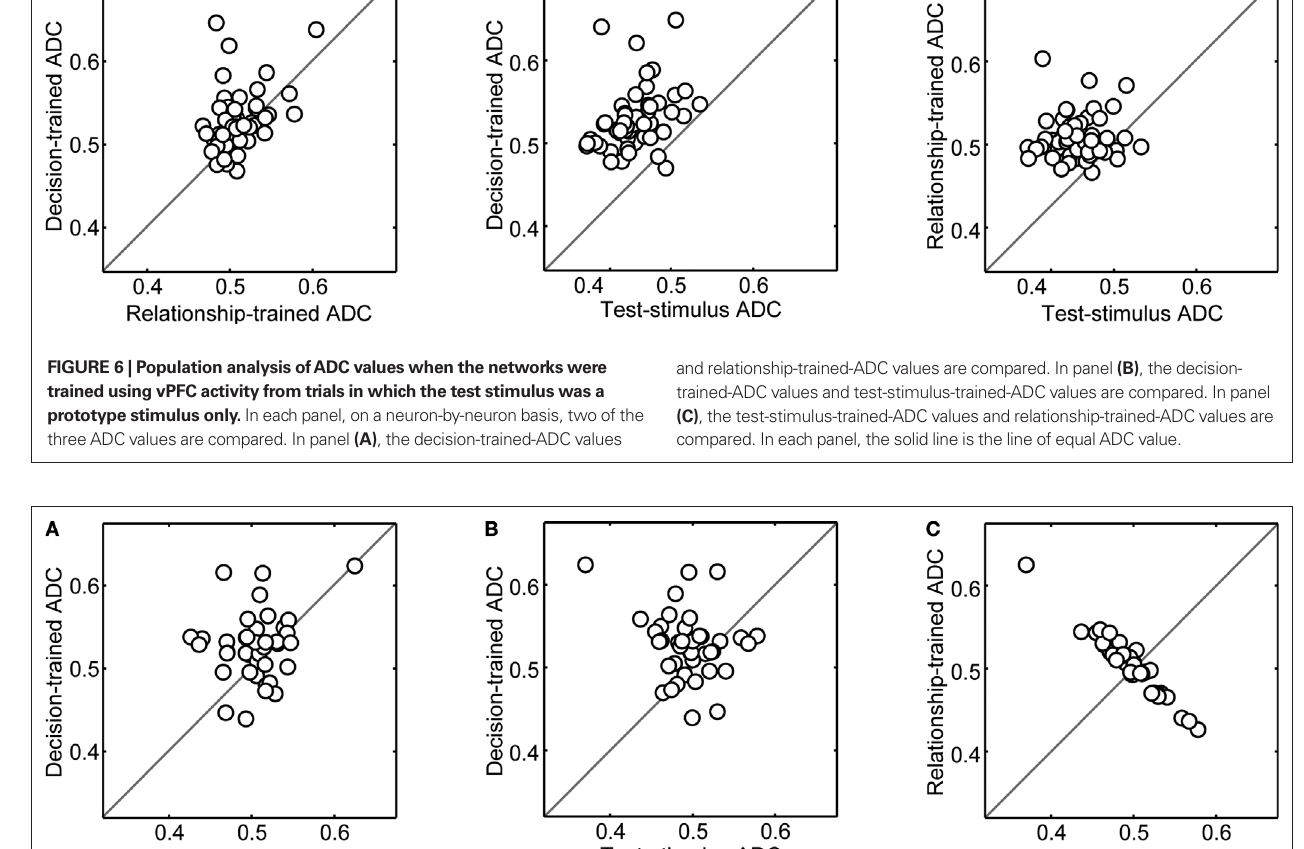
FIGURE 7 | Population analysis of ADC values when the networks were trained using data generated from only one reference-stimulus prototype and evaluated with data from the other reference stimulus. In panel (A) , the decision-trained-ADC values and relationship-trained-ADC values are compared.